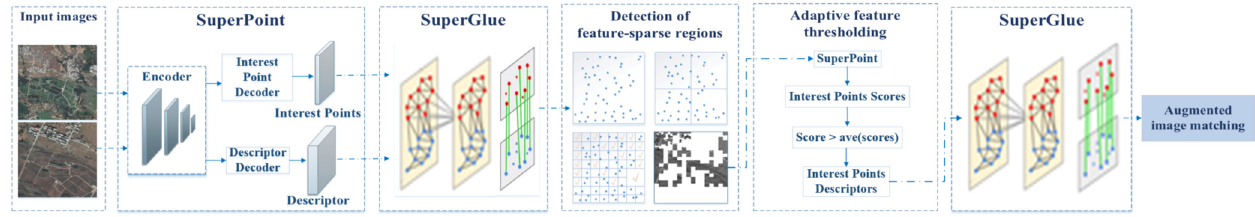
Figure 1. Flow chart of the SD-ME algorithm.